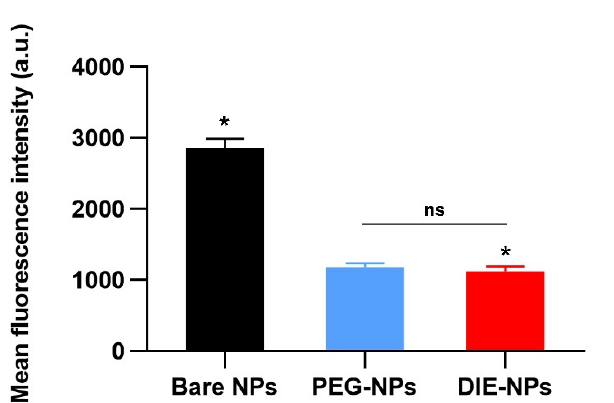
Figure 13. Cellular uptake by macrophage cells of non-coated bare PLGA nanoparticles (Bare NPs) and the stealth functionality of DIE-NPs in comparison to PEGylated nanoparticles (PEG-NPs). ns = no statistically significant difference in mean fluorescence intensity between PEG-NPs and DIE- NPs ( p > 0.05). * denotes significance in mean fluorescence intensity between Bare NPs and DIE-NPs ( p < 0.05). Data are given as mean ± standard deviation ( n = 3).